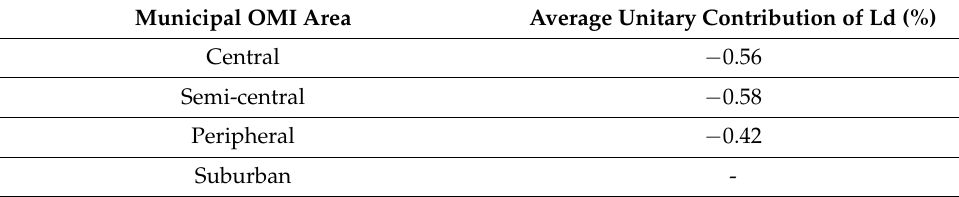
Table 8. Average unitary influence of the variable Ld for the four municipal OMI areas of the city of